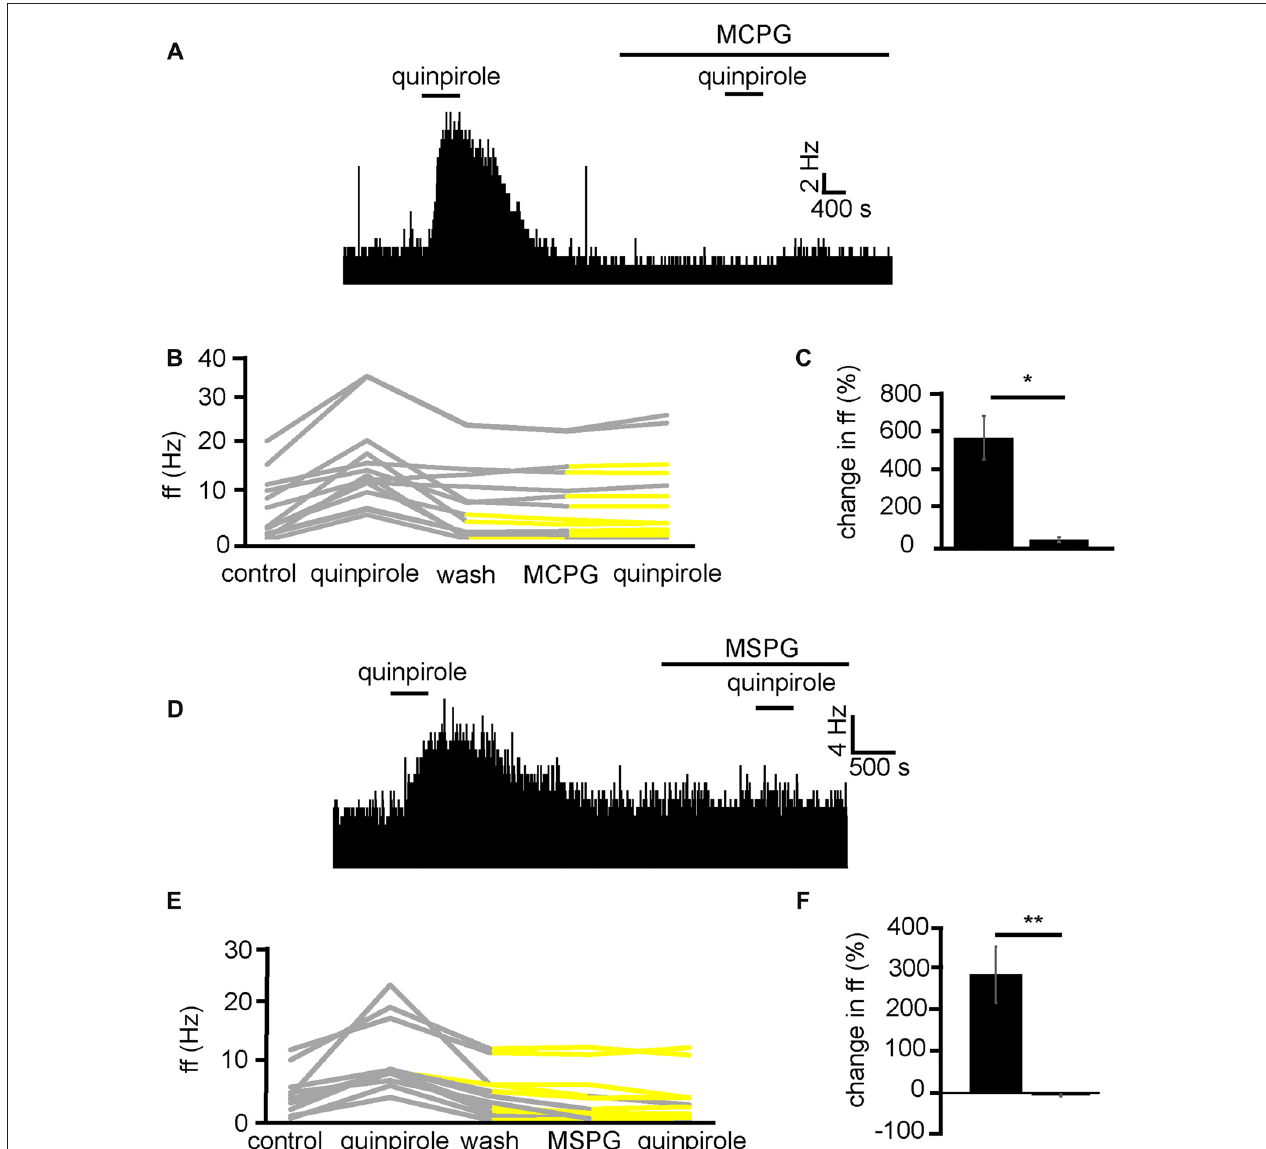
FIGURE 8 | Excitatory effects of D2-like receptor agonists require metabotropic glutamate receptors. (A) Excitatory responses to quinpirole that are not present for the same neuron in response to quinpirole in the presence of MCPG. (B) Changes in firing frequency for 13 VP neurons to application of quinpirole and quinpirole in the presence of MCPG, similar to that illustrated in panel (A) . Firing frequency was measured before the application of quinpirole, during the application of quinpirole, after wash out of quinpirole, during application of MCPG and finally during the application of quinpirole in the presence of MCPG. Responses characterized by significant ( P < 0.05) changes in firing frequency are in gray, the other ones in yellow. (C) Significant differences in firing frequency in response to quinpirole compared to quinpirole in the presence of MCPG. (D) Excitatory responses to quinpirole that are not present for the same neuron in response to quinpirole in the presence